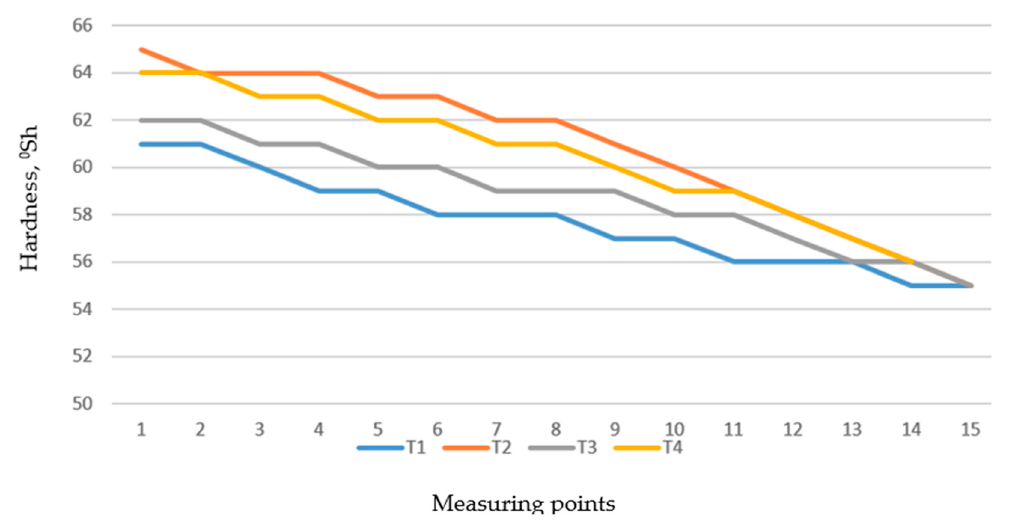
Figure 5. The hardness values, Shore D, for the four types of fittings.